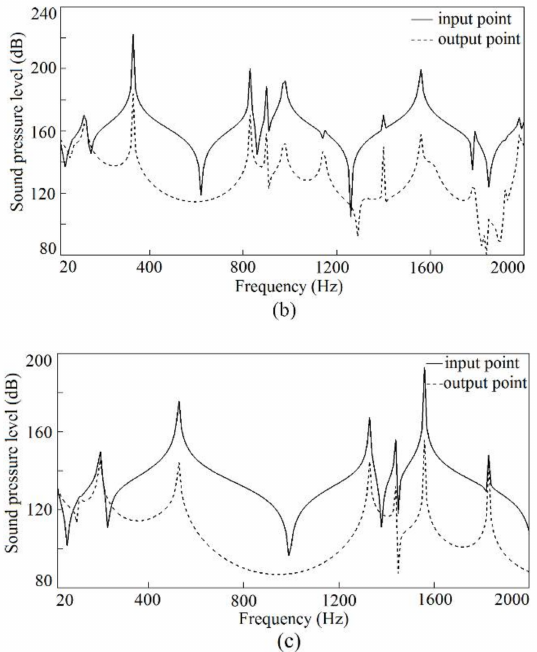
Figure 14. The sound pressure level of the inlet and outlet of the silencer ( v = 55 m/s): ( a ) T = 760 K; ( b ) T = 560 K; ( c ) T = 960 K.